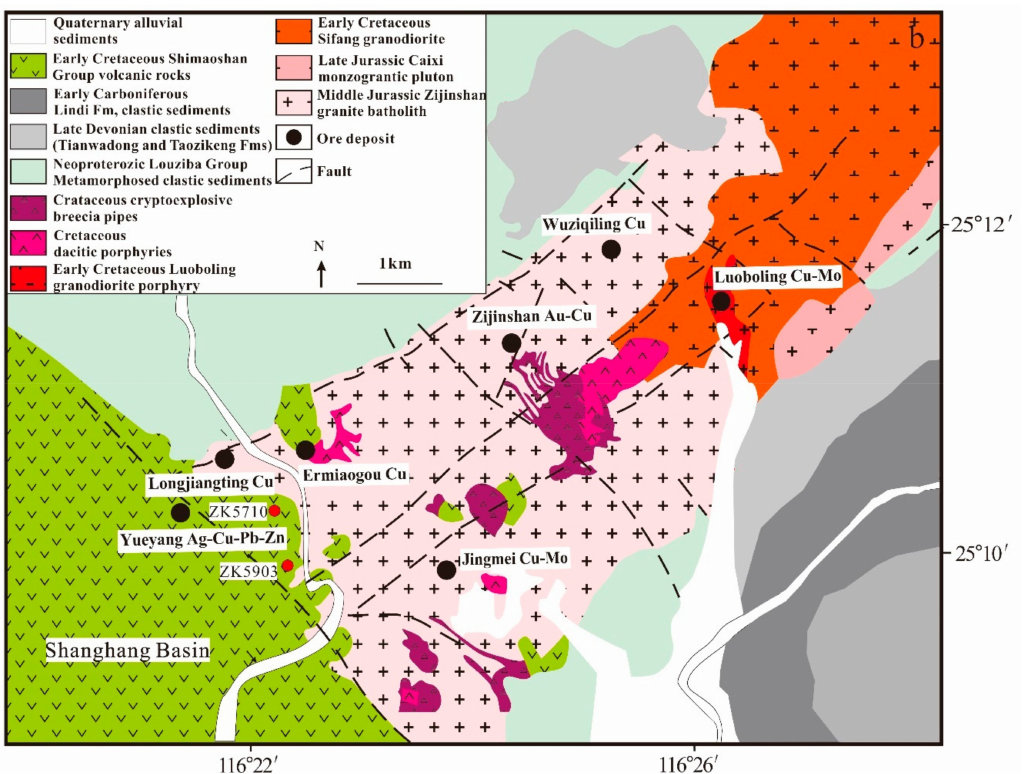
Figure 2. Geological map of the Zijinshan Cu–Au ore district showing a cluster of porphyry Cu–Mo and porphyry-epithermal Au–Cu deposits, modified from